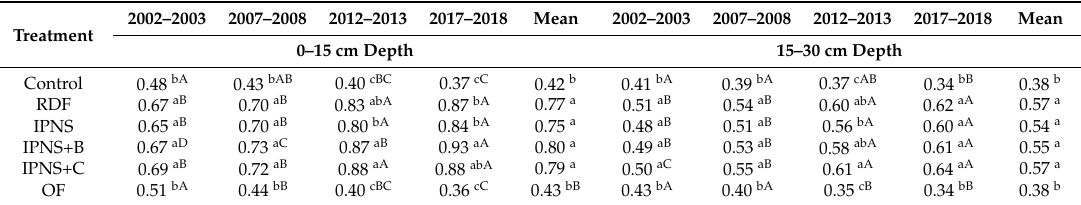
Table 9. Effects of different nutrient management options on soil DTPA extractable Zn content (mg kg − 1 ) at soil depths of 0–15 and 15–30 cm after 5 RWS cycle intervals.